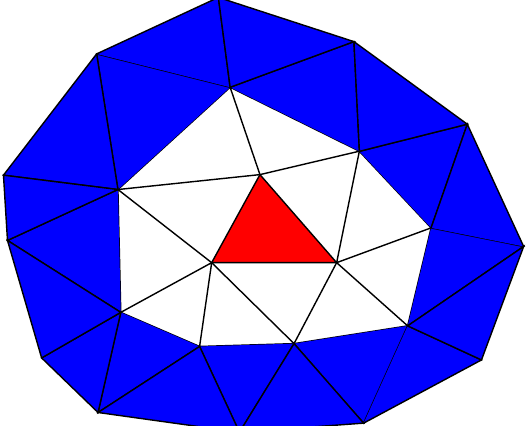
Figure 17. Red: user input seed triangle ( C ( t s ,0 ) ). Blue: topological circle C ( t s ,2 ) . White: topological circle C ( t ,1 ) . Red + White + Blue: topological ball B ( t s ,2 ) . The initial guess for the analytic form g () is computed with C ( ts ,0 ) ∪ C ( ts ,2 )